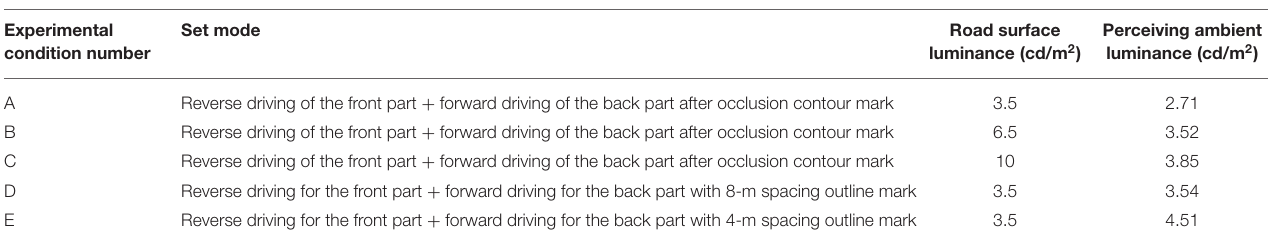
TABLE 2 | Five different experimental conditions were set in the experiment. Experimental condition